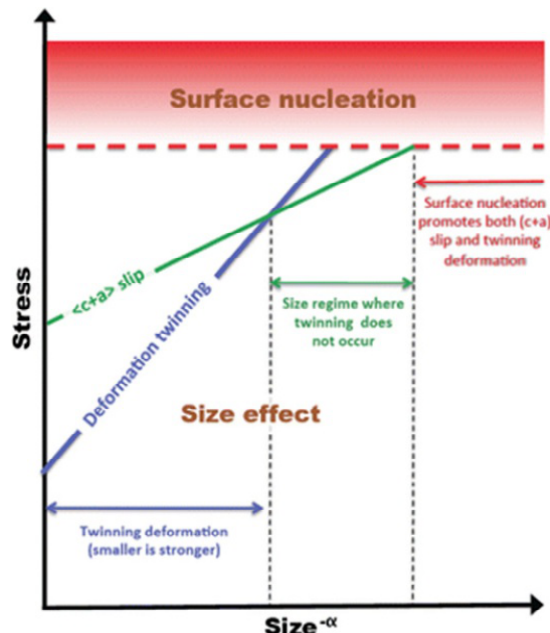
Fig. 37. A schematic diagram presenting the corre- lation of the size and surface effects on the defor- mation twinning. á is a positive exponent, 0 <  